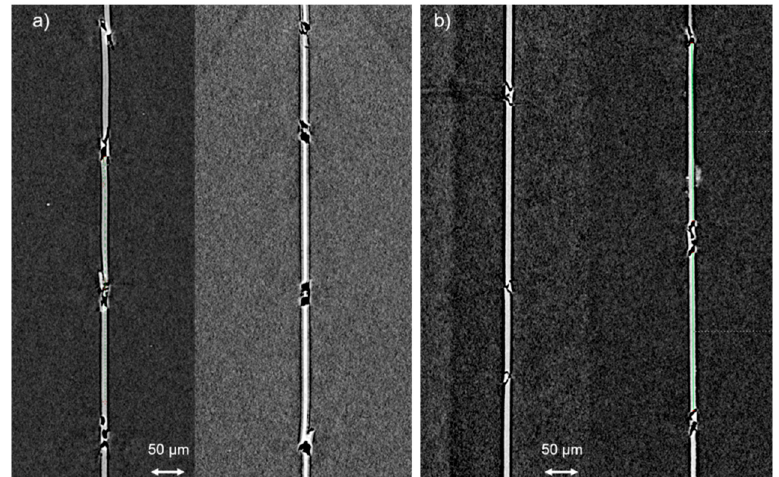
Figure 7. Post mortem X-ray projections of four Broutman test specimens taken under identical settings: with ( a ) toughened matrix and ( b ) non-toughened matrix. All show the already mentioned phase contrast effect and several locations of fiber fracture with two fracture planes each and a small fracture piece in between them.